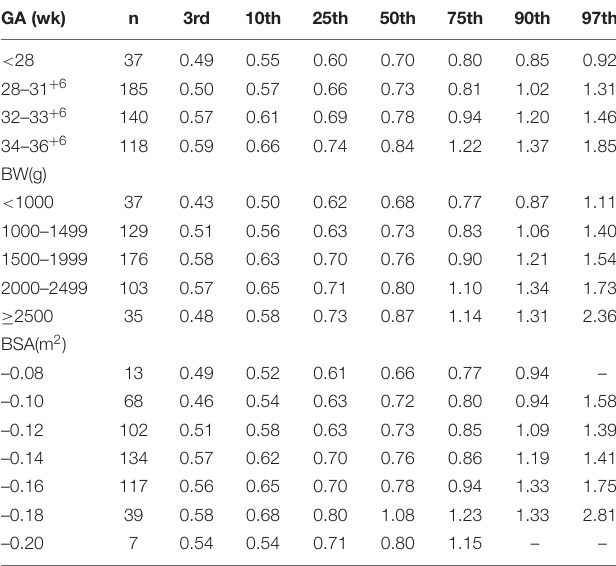
TABLE 11 | Doppler maximum velocities of MV-E/A (from 3rd to 97th centiles) in relation to GA, BW, and BSA in preterm